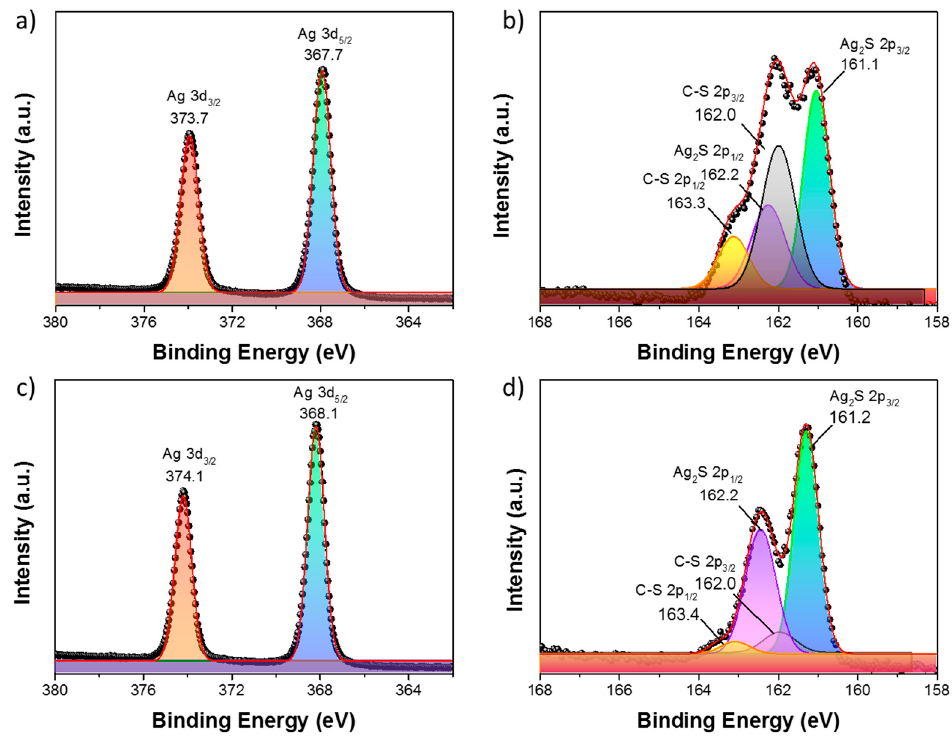
Figure 4. XPS spectra of Ag 3d ( a , c ) and S 2p ( b , d ). Elements from Ag 2 S / rGO measured before ( a , b ) and after ( c , d ) electrochemical cyclic voltammetry (CV)test. Table 2. Details of the fitting peaks of S before the HER reaction.